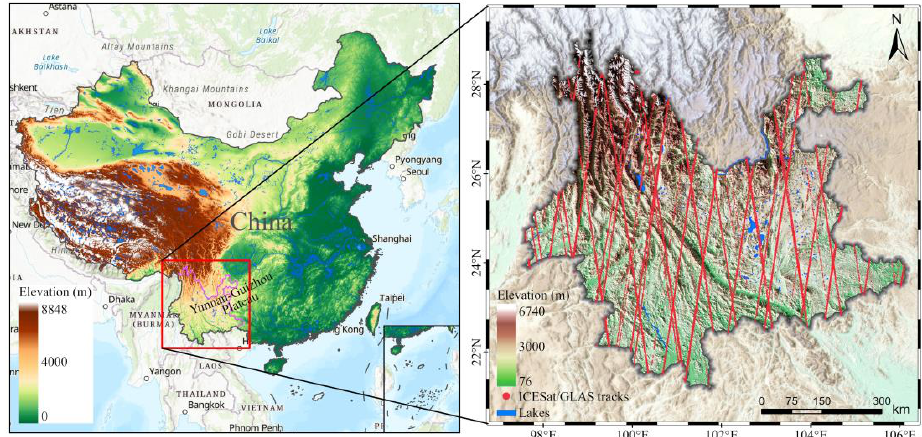
Figure 1. Study area: Yunnan Province, China. The colour changes on the graphic reflect changes in surface elevation, while the red dots indicate the ICESat satellite’s laser footprint on the ground.